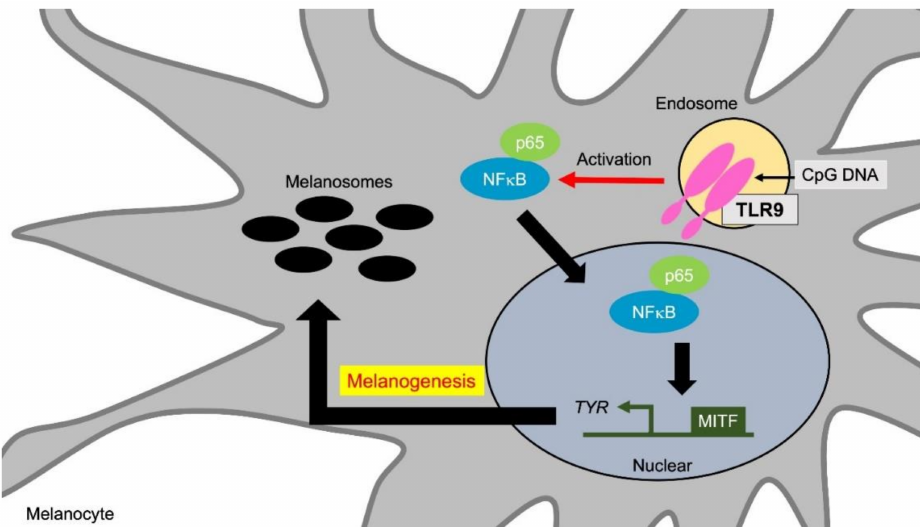
Figure 6. TLR9 promotes melanogenesis via NF κ B activation. TLR9 stimulation increases melanin synthesis via TYR and PMEL induction through NF κ B activation. TYR and PMEL induction by TLR9 stimulation is further enhanced by the synergistic e ff ect with UVB irradiation. Abbreviations: TLR: toll-like receptor; TYR: tyrosinase; MITF: microphthalmia-associated transcription factor; PMEL: premelanosome